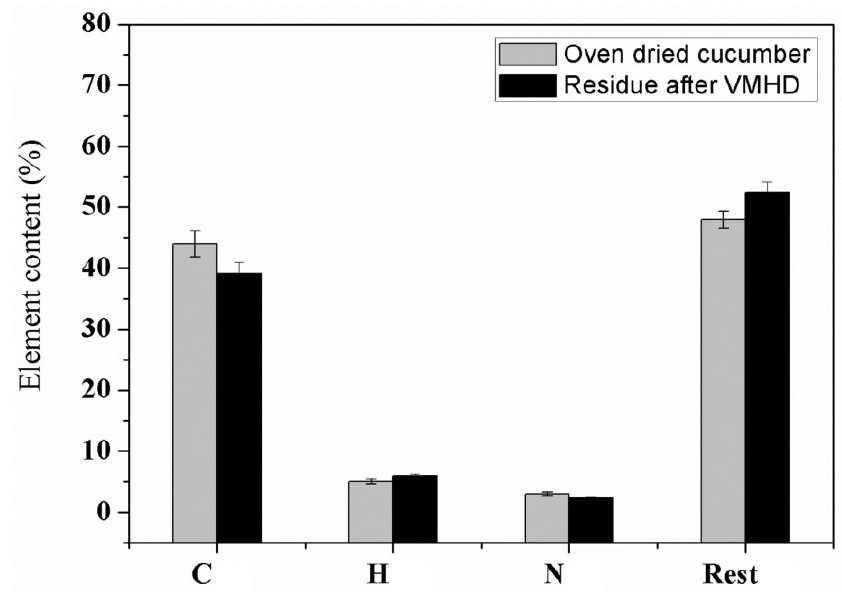
Figure 5. CHN analysis of cucumbers and their residues obtained from VMHD (500 W, 300 mbar).